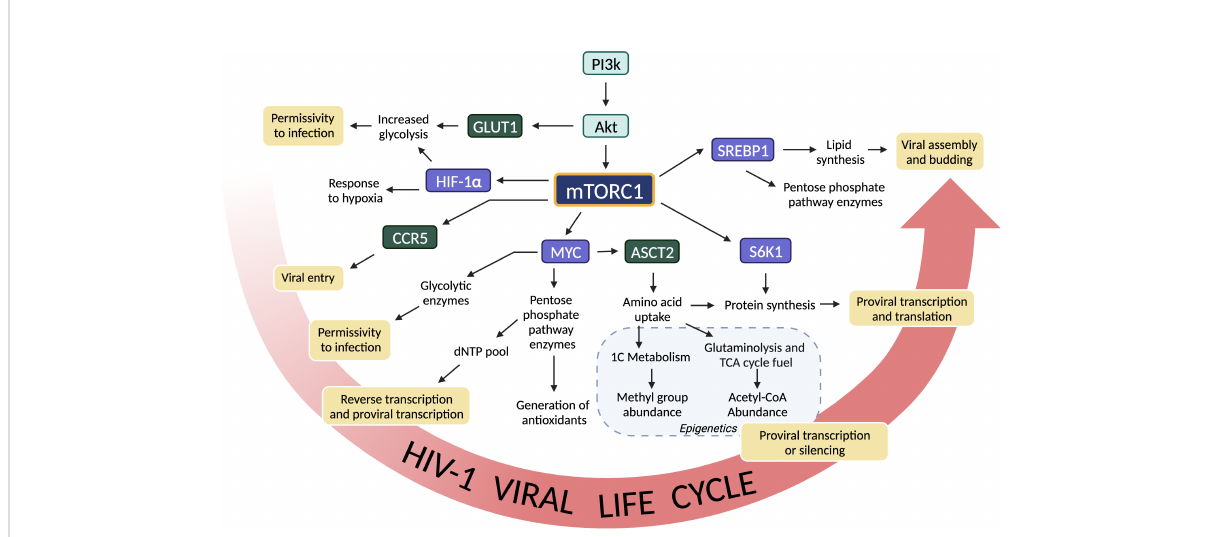
FIGURE 2 mTORC1 is involved of each step of the HIV-1 viral life cycle. Factors downstream of mTORC1 lead to increased permissivity to infection, reverse transcription, proviral transcription, epigenetic control of the provirus, protein translation, virion assembly, and budding. mTORC1 affects these stages of the viral life cycle by regulating signaling and metabolic pathways. Kinases upstream of mTORC1 are shown in light blue, surface proteins are shown in green, and transcription factors are shown in